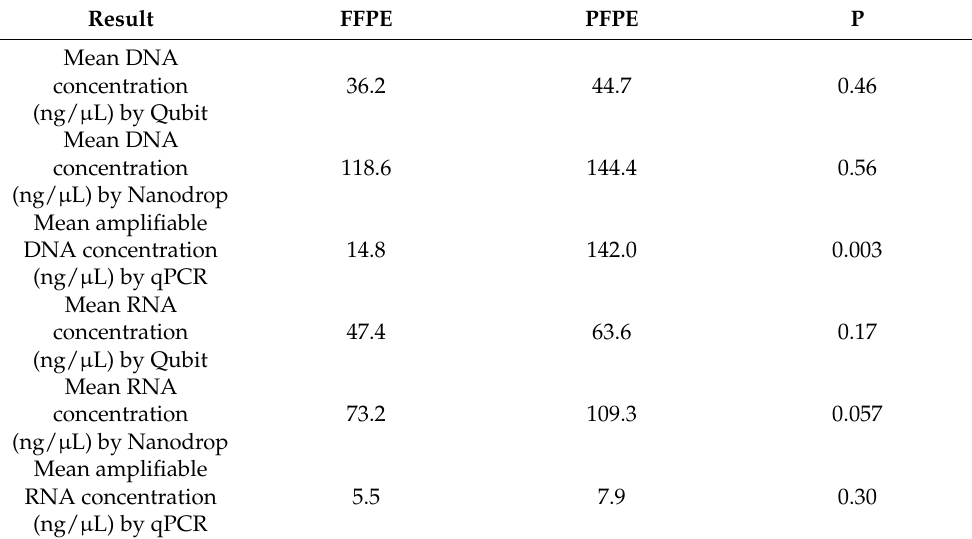
Figure 1. Histomorphology of PAXgene-fixed and Formalin-fixed pancreatic adenocarcinoma spec- imens. Most slides derived from PAXgene-fixed tissue showed good quality histomorphology with appropriate contrast (( A ) H&E, 100×), comparable to Formalin-fixed tissue (( C ) H&E, 100×). Occasionally, slides from both fixation methods showed a pale appearance with reduced contrast (( B ) PAXgene, H&E, 100 × ; ( D ) Formalin, H&E, 100 × ), with no significant difference in the frequency of this finding. Table 2. Nucleic acid yields in Formalin-fixed and PAXgene-fixed tissue